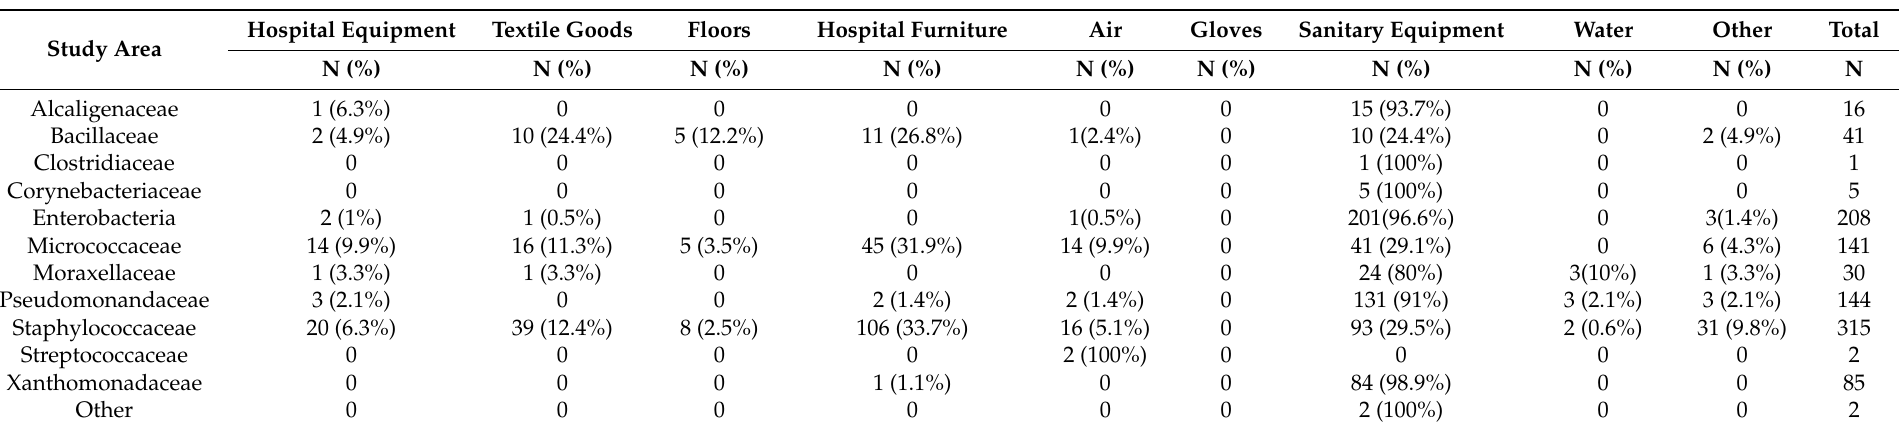
Table 5. Distribution of bacteria families by the sampling area 1 .